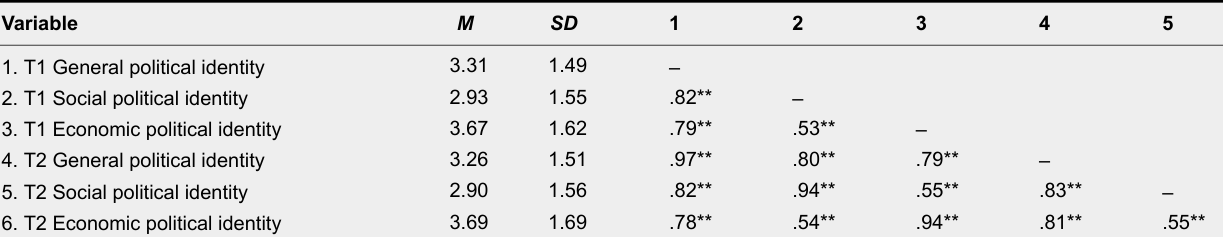
Means, SDs and Correlations Between All Variables Used in Study 1: All Participants